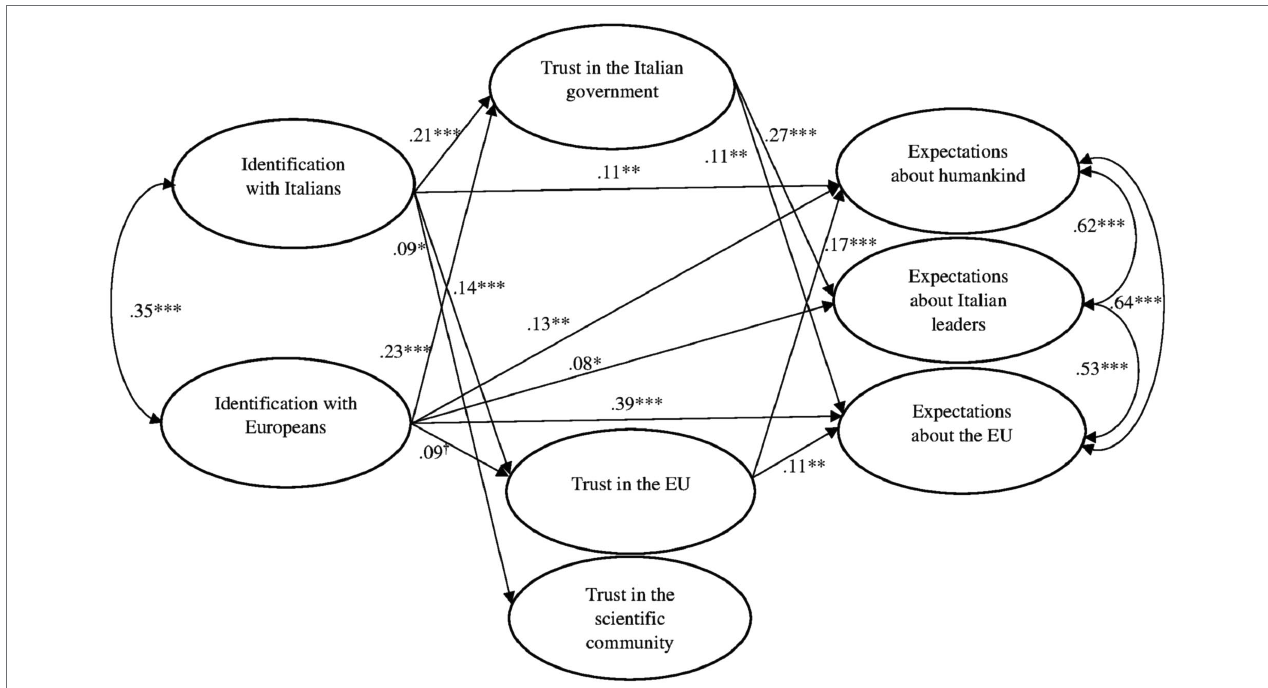
FIGURE 1 | Standardized solution of the model testing the relations among identification with Italians and Europeans, trust in institutions and positive expectations for the future. † p = 0.053; * p < 0.05; ** p < 0.01; and *** p < 0.001. Control variables (age, gender, place of residence, political orientation, and experience with COVID-19) were included in the model but are not shown in the